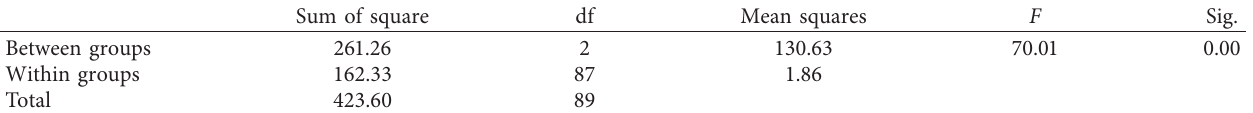
Table 4: One-way ANOVA (vocabulary